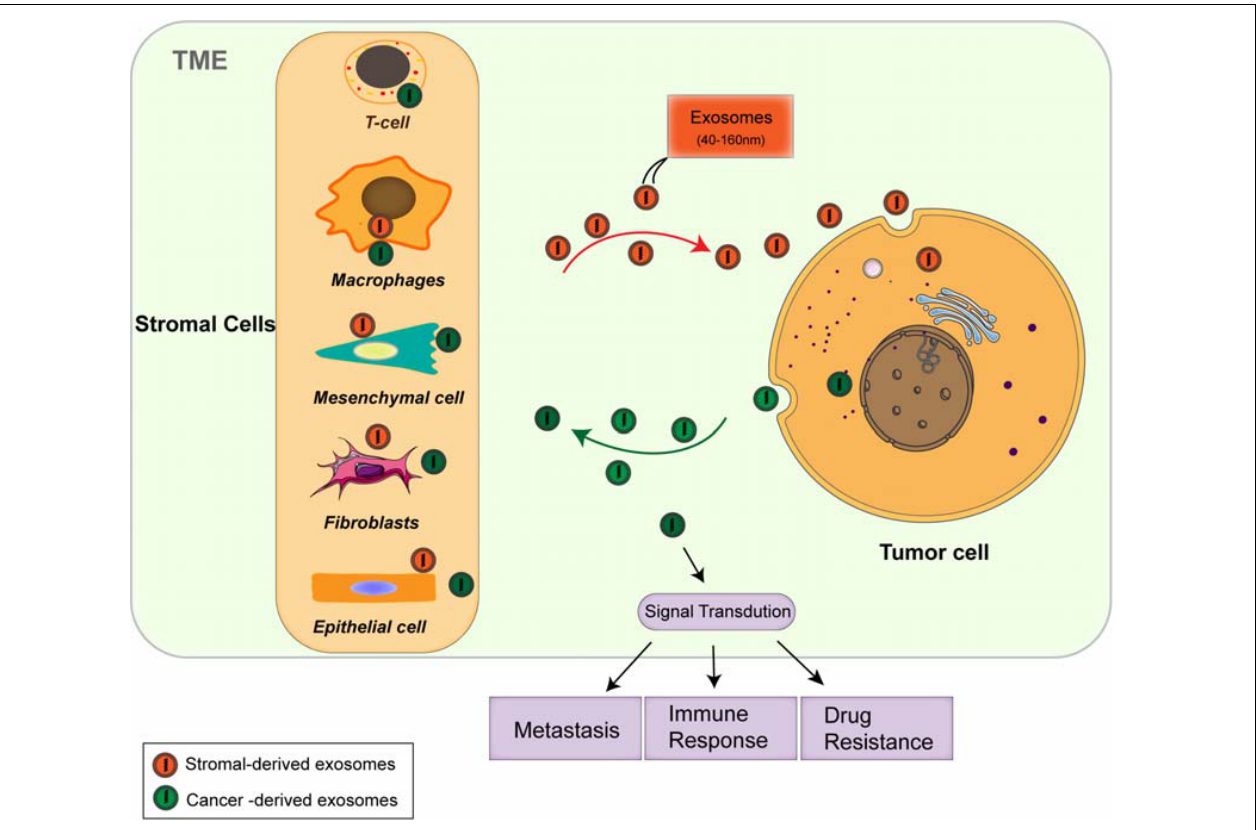
FIGURE 1 | Both cancer cells and stromal cells release exosomes within the tumor microenvironment (TME). The stromal cells include cancer-associated fibroblasts (CAFs), endothelial cells, immune cells such as myeloid-derived suppressor cells (MDSCs), regulatory T cells (Tregs), and tumor-associated macrophages (TAMs). Both tumor cells and stromal cells release different types of the exosomes. The circulation of these exosome cargoes regulates tumor metastasis, immunoresponse, and chemoresistance through multiple signaling